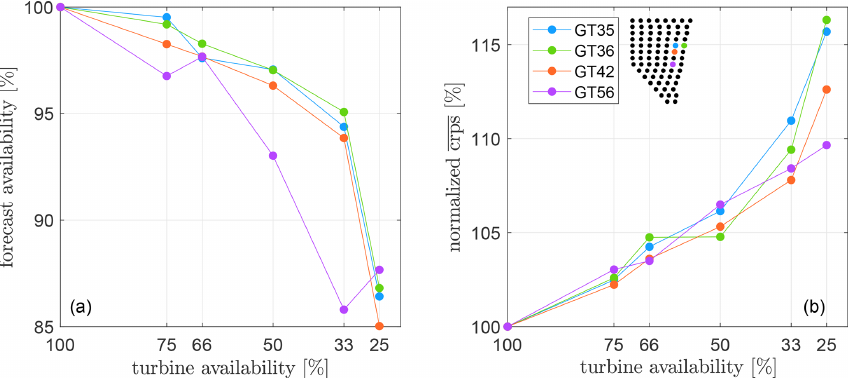
Figure 6. (a) Forecast availability (in %) and (b) crps normalized with respect to 100% turbine availability (in %) for reduced turbine availability and selected example turbines. The wind farm layout visualizes the turbines’ positions.